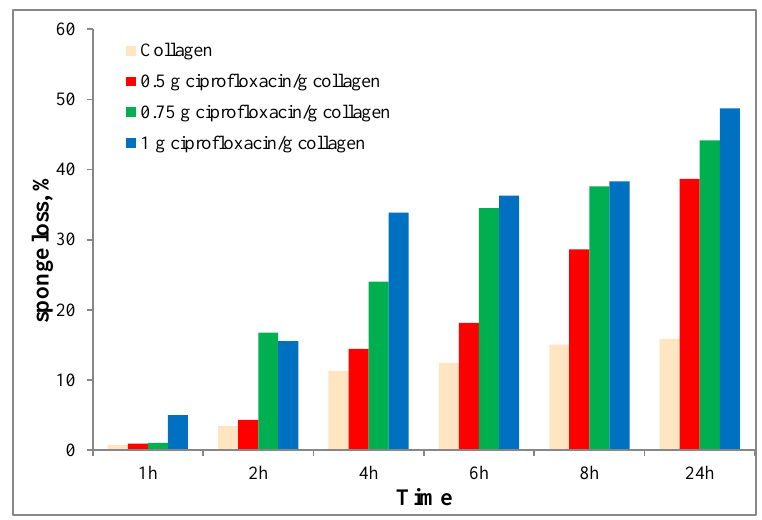
Figure 2. Enzymatic degradation behavior for the studied materials.